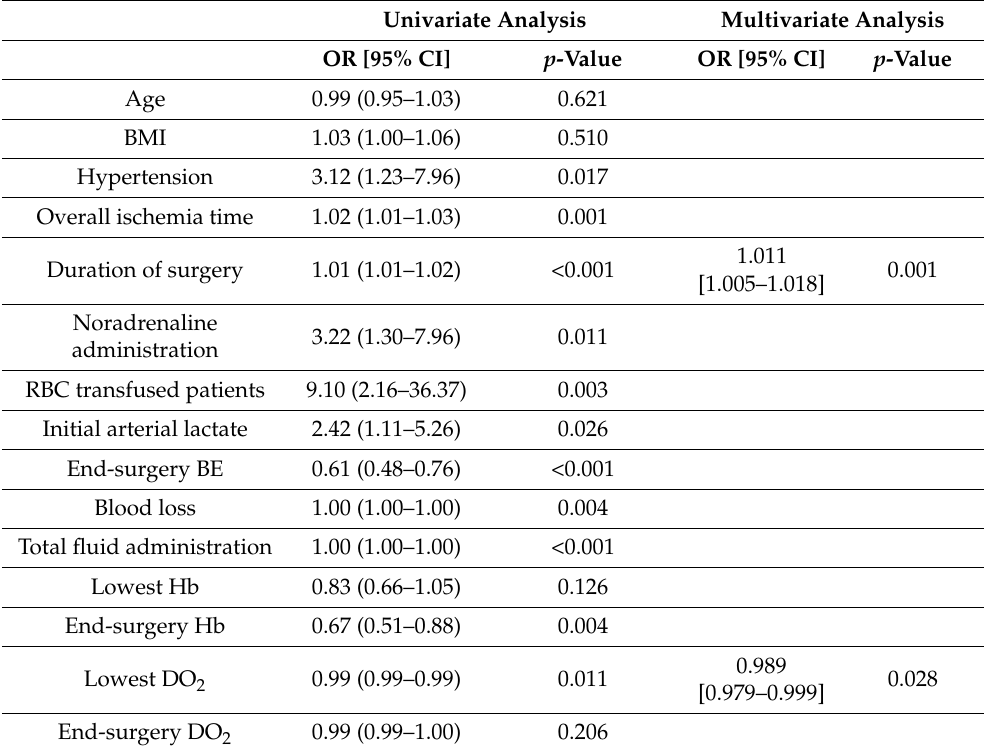
Table 6. Univariate and Multivariate analysis for pre- and intraoperative factors associated with ES-ALC (>5 mmol/L) in 108